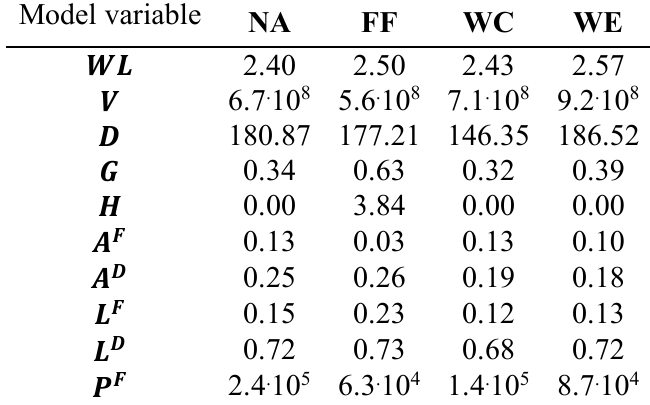
Table A7. Average values of different model variables obtained for the synthetic experiment additional scenario #6 with dam construction and four water management strategies (NA: No Actions; FF: Fighting Floods; WC: Water Conservation; WE: Water